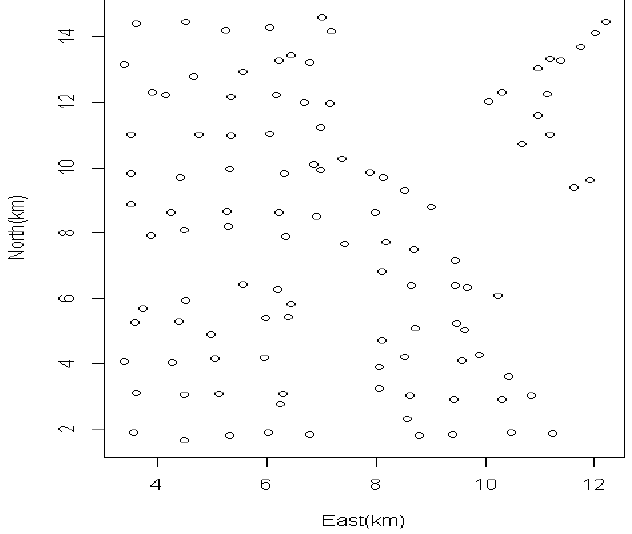
Figure 2. Spatial distribution of soil and groundwater sampling sites.